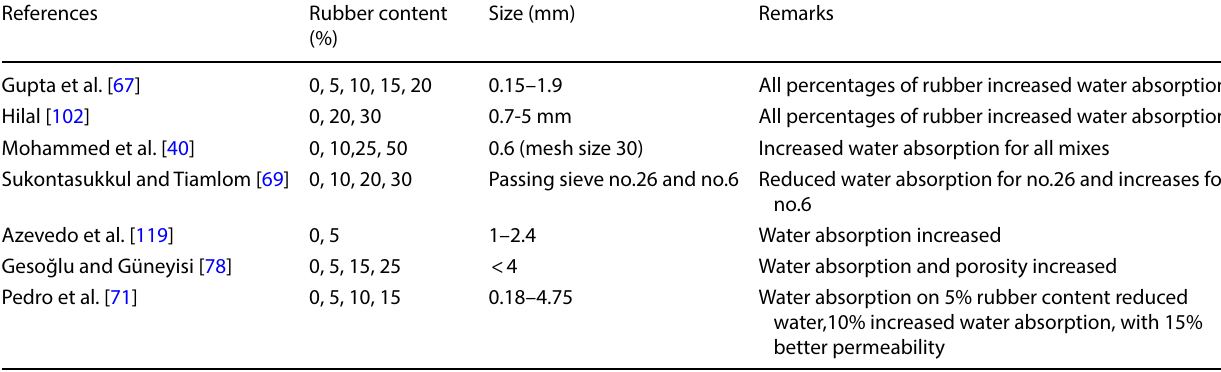
Table 5 Effect of waste recycled tire rubber on water absorption and Porosity of concrete